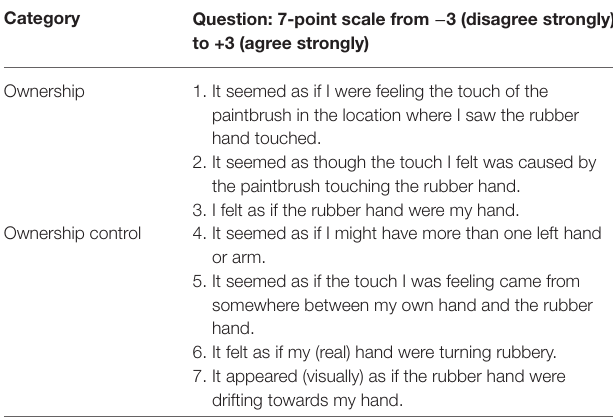
TABLE 1 | Questionnaire comprising seven items that were classified into two